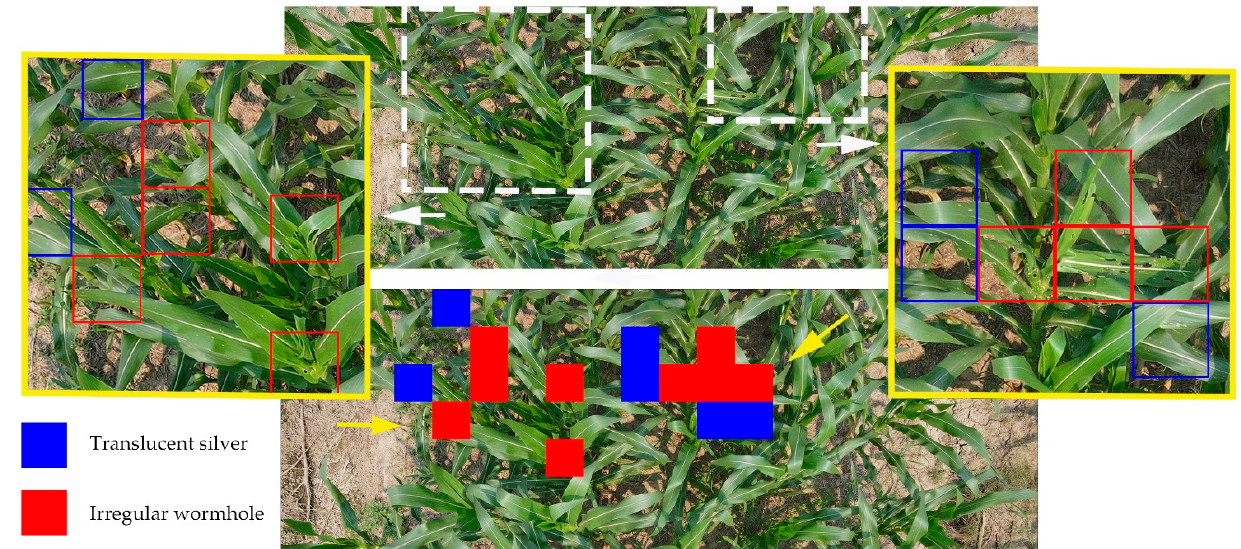
Figure 9. Visualization of model’s outputs. The upper part of the figure is the original image, the lower part is the image after adding the infected color block, and the left and right yellow image cells are the enlarged image of the infected area.